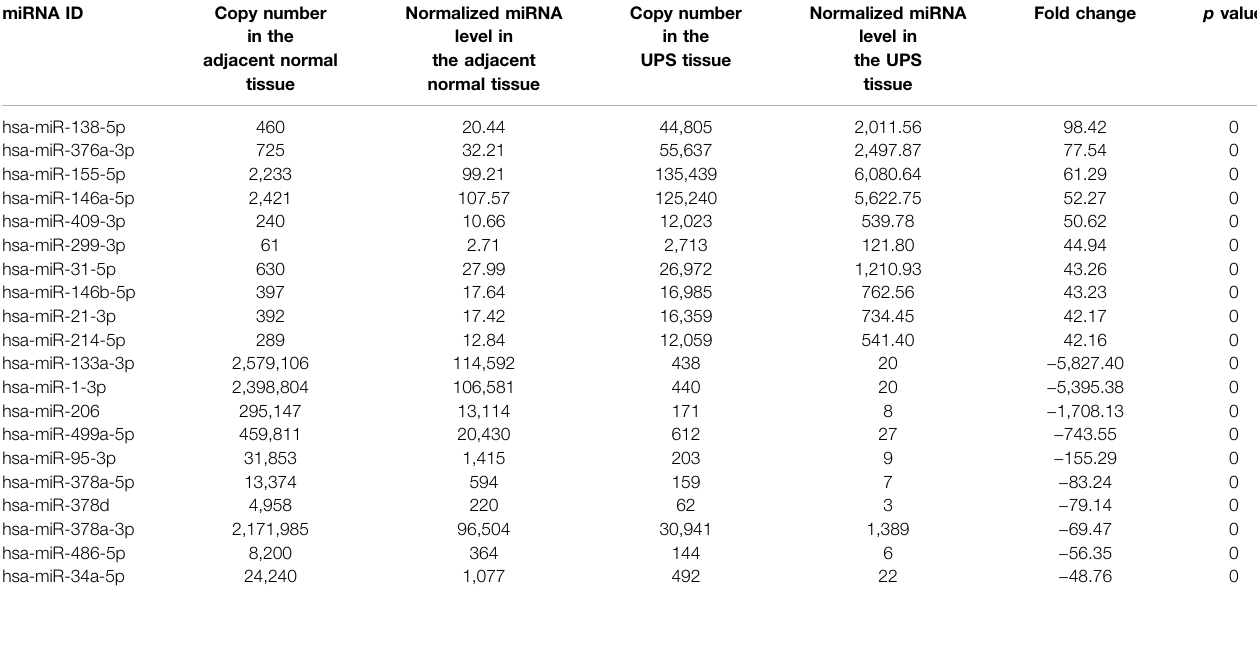
TABLE 3 | Top 10 upregulated and downregulated differentially expressed known miRNAs in the UPS tumor tissue compared with the adjacent normal tissue. miRNA